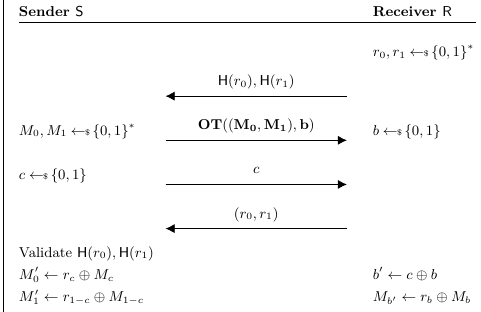
Figure 2: Generic construction of ROT from OT, using a black-box